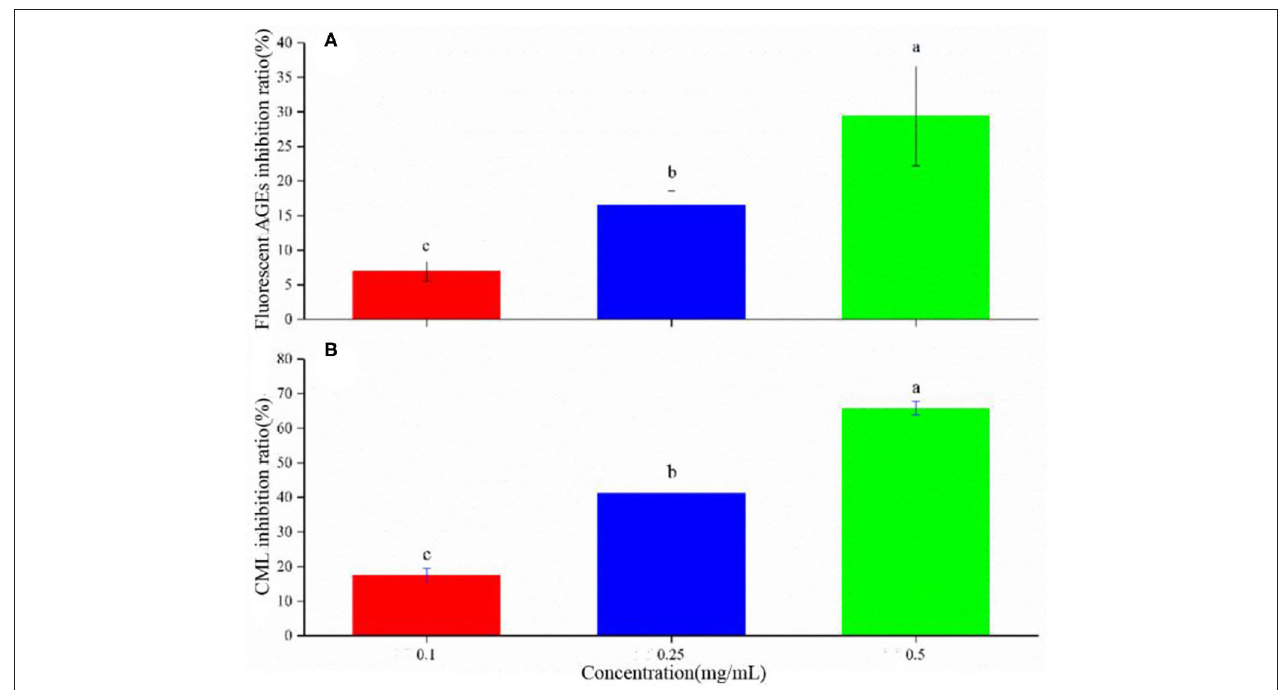
FIGURE 4 | Inhibition rate of AGEs (A) and CML (B) in yogurt. Different letters indicated significant differences ( P < 0.05).